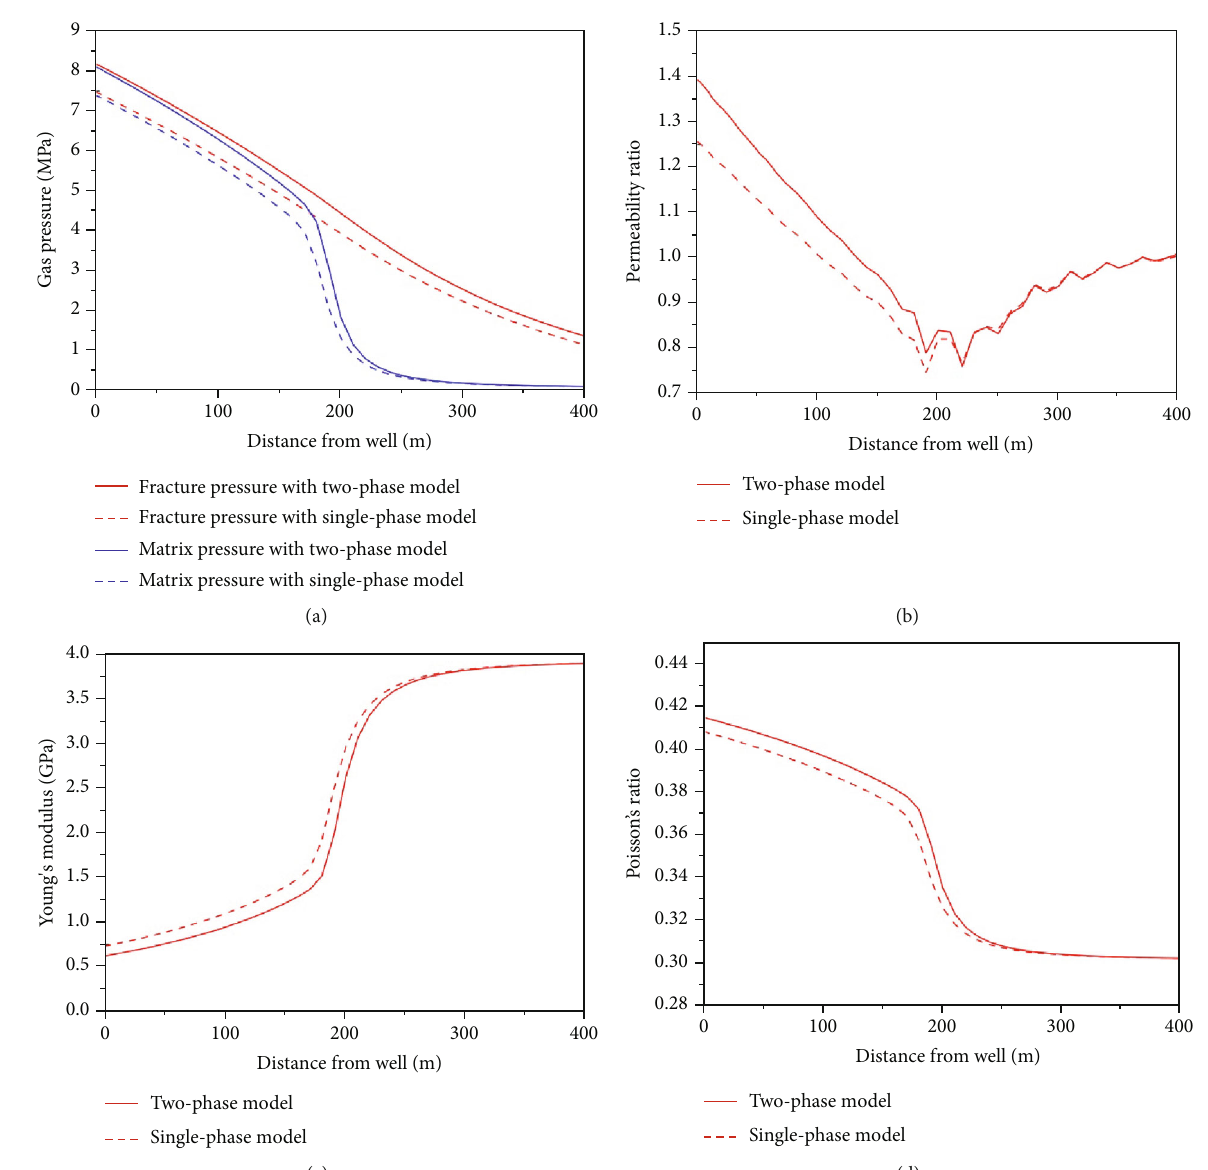
Figure 11: Impact of multiphase fl ow on fl uid transfer and coal